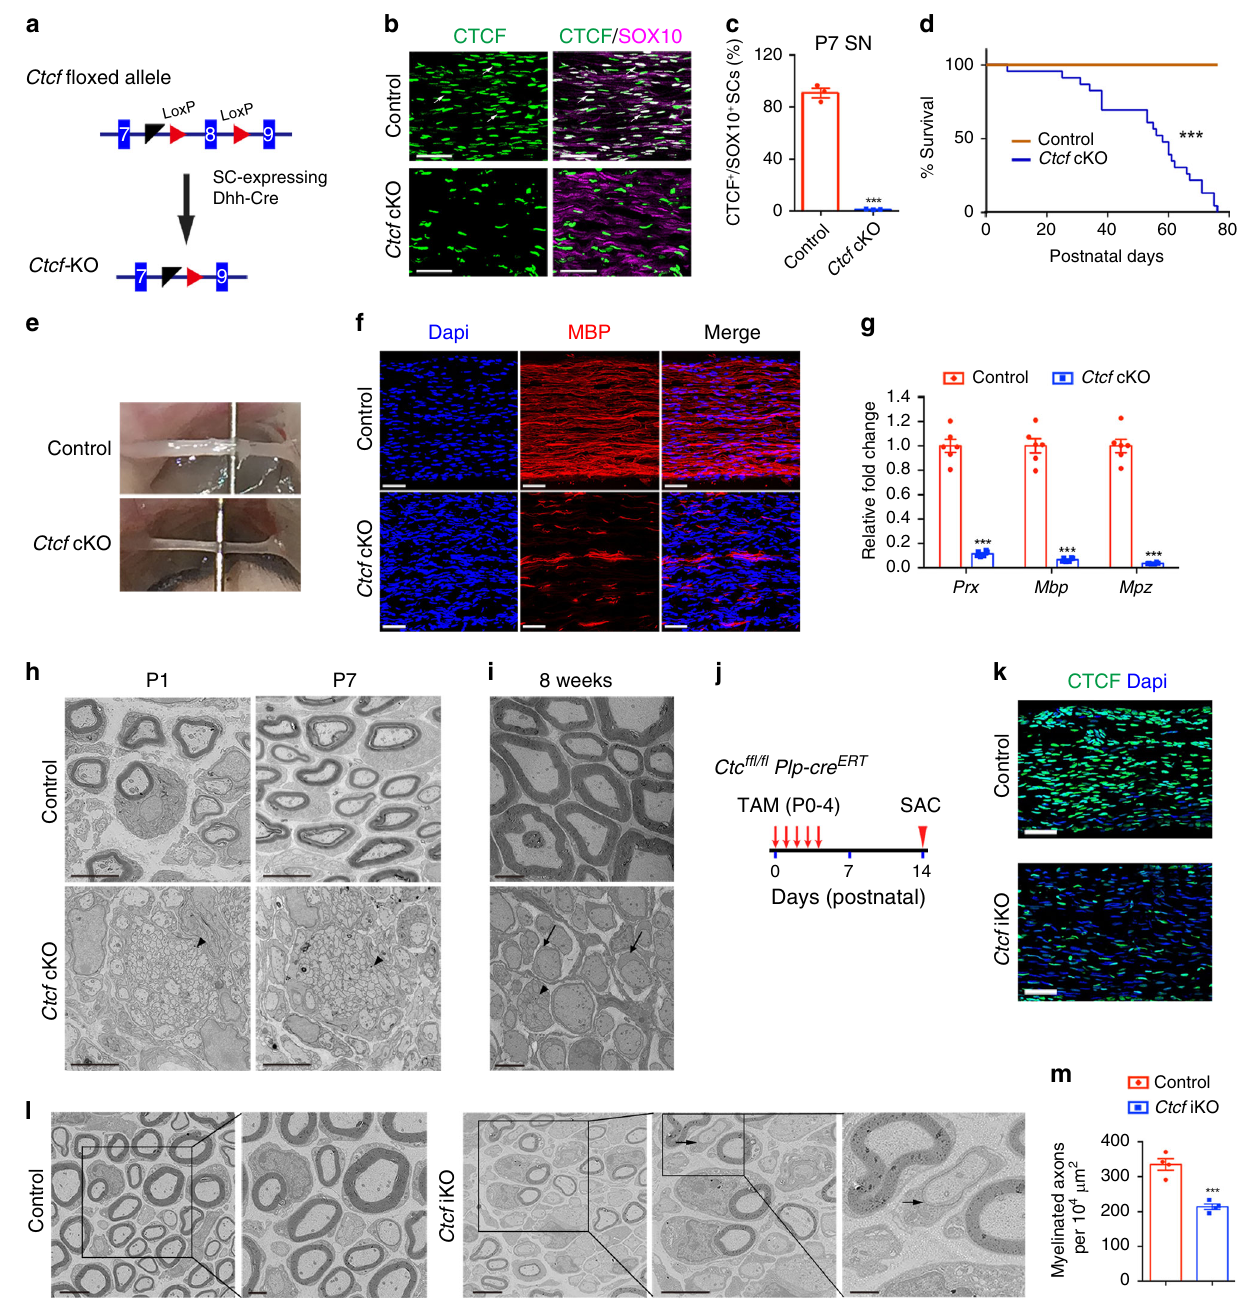
Fig. 3 CTCF is required for peripheral nerve ensheathment. a Excised exon 8 of the fl oxed Ctcf allele by Dhh-Cre . b Co-labeling of CTCF with SOX10 in control and mutant sciatic nerves at P7 ( n = 3 animals/genotype). Arrows indicate SOX10 + /CTCF + SCs. Scale bars: 50 μ m. c The percentage of CTCF + nuclei in SCs (SOX10 + ) from control and Ctcf cKO sciatic nerves at P7. n = 3 animals/genotype, P = 1.73E-05. d Survival curves of control and Ctcf cKO mice. n = 25 for control and n = 23 for Ctcf cKO mice, *** P < 0.001. e Representative photographs of sciatic nerves from P13 control and Ctcf cKO mice. n = 3 animals/genotype. f Immuno fl uorescence labeling of MBP (red) in P7 control and Ctcf cKO sciatic nerves. n = 3 animals/genotype. Scale bars: 50 μ m. g The mRNA levels of myelin-related genes in P7 control and Ctcf cKO sciatic nerves. n = 6 animals/genotype. P ( Prx ) = 1.9E-08, P ( Mbp ) = 2.0E-08, P ( Mpz ) = 8.5E-09. h, i Ultrastructure of control and Ctcf cKO sciatic nerves at ( h ) P1 and P7 and at ( i ) 8 weeks. n = 3 animals/genotype. Arrows and arrowheads indicate immature SCs and unsorted axons, respectively. Scale bars: 4 μ m. j A diagram showing the tamoxifen (TAM) administration scheme. k Immuno fl uorescent labeling of CTCF (green) nuclei in control and Ctcf iKO sciatic nerves at P14. Scale bars: 50 μ m. n = 3 animals/genotype. l EM images of P14 sciatic nerves from control and Ctcf iKO mice. n = 4 animals/genotype. Arrow indicates myelin membrane. Scale bars: 4 μ m, and 1 μ m in the inset on the right panel. m Myelinated axon numbers 10 − 4 μ m − 2 sections of P14 sciatic nerves from control and Ctcf iKO mice. n = 4 animals/genotype, P = 0.0006. Data are presented as means± SEM., *** P < 0.001; Statistical analyses performed using two-tailed unpaired Student ’ s t -test; Log-rank test used for survival curve. Source data are provided as a Source Data fi